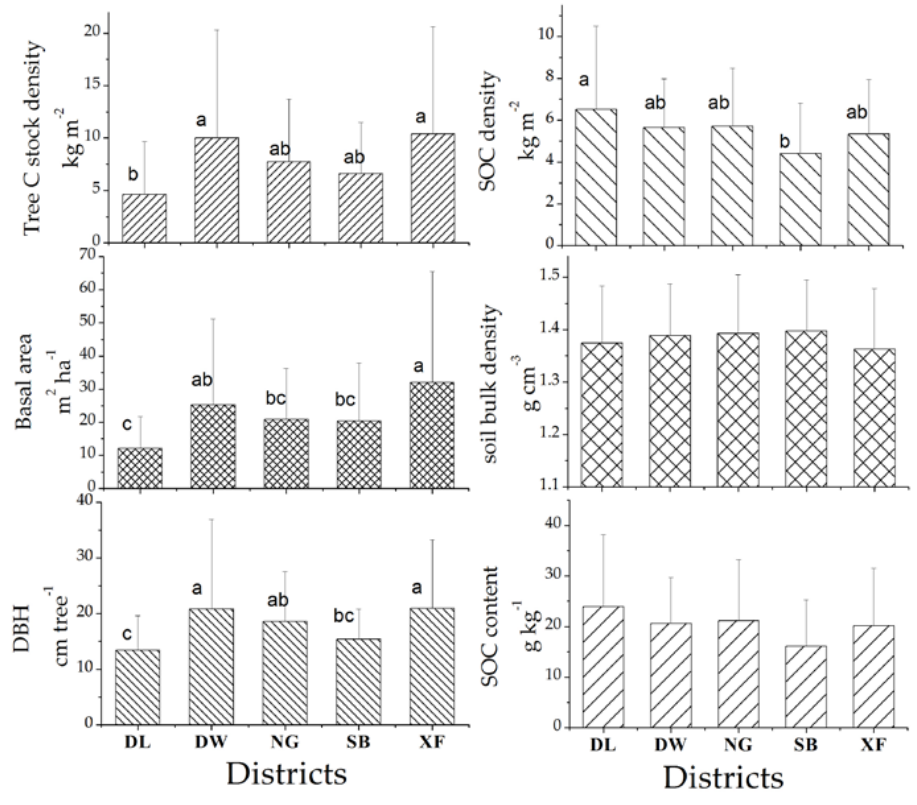
Figure 5. Tree biomass differences in tree C stock density, basal area, and diameter at breast height (DBH) ( left ), plus differences in soil organic carbon (SOC) density, SOC content, and soil bulk density ( right ) among different administrative districts in Harbin City. Note: DL, Daoli District; DW, Daowai District; NG, Nangang District; SB, Songbei District; XF, Xiangfang District. The same letters (e.g., a and a, a and ab) indicate no significant differences, and different letters (e.g., a and b, or b and c) indicate significant differences ( p < 0.05) based on the one-way ANOVA test statistics.